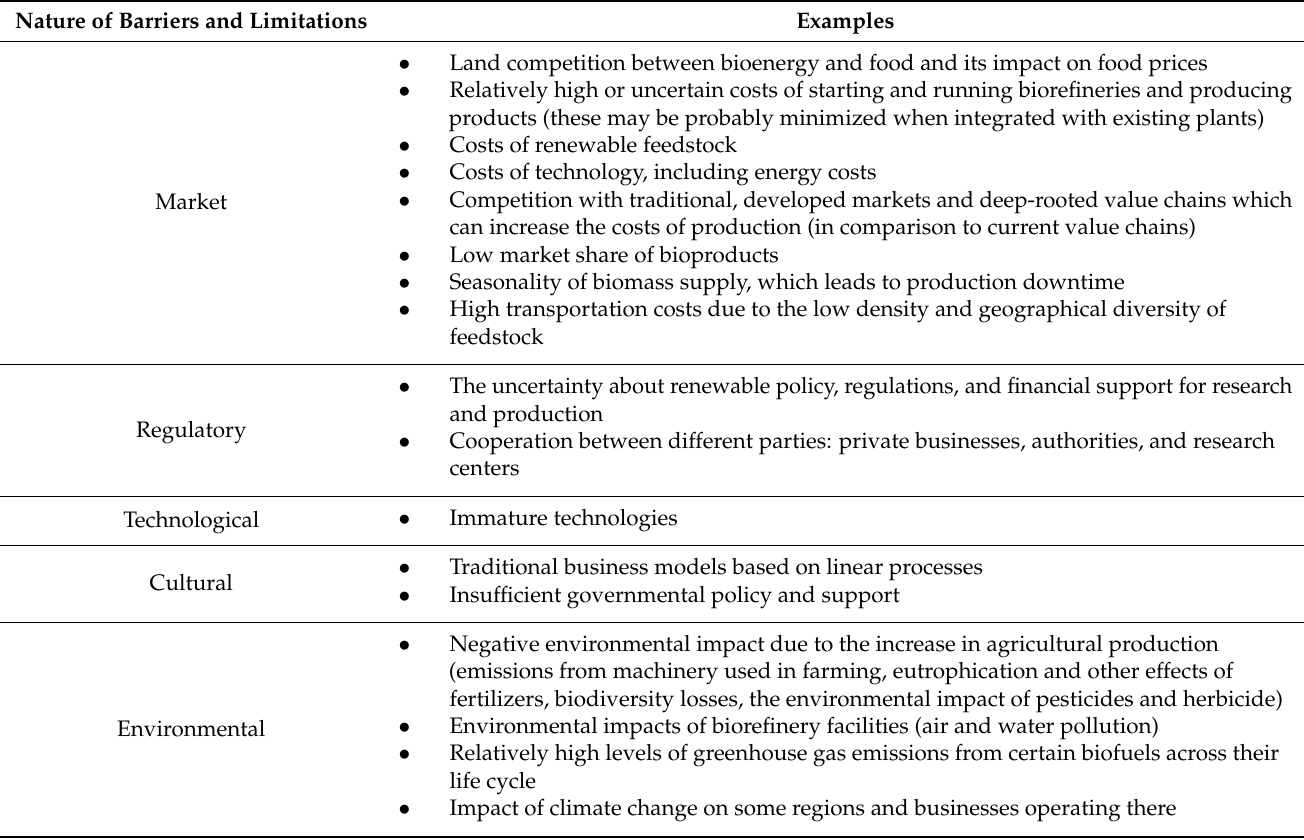
Table 3. Limitations of implementing the premises of circular